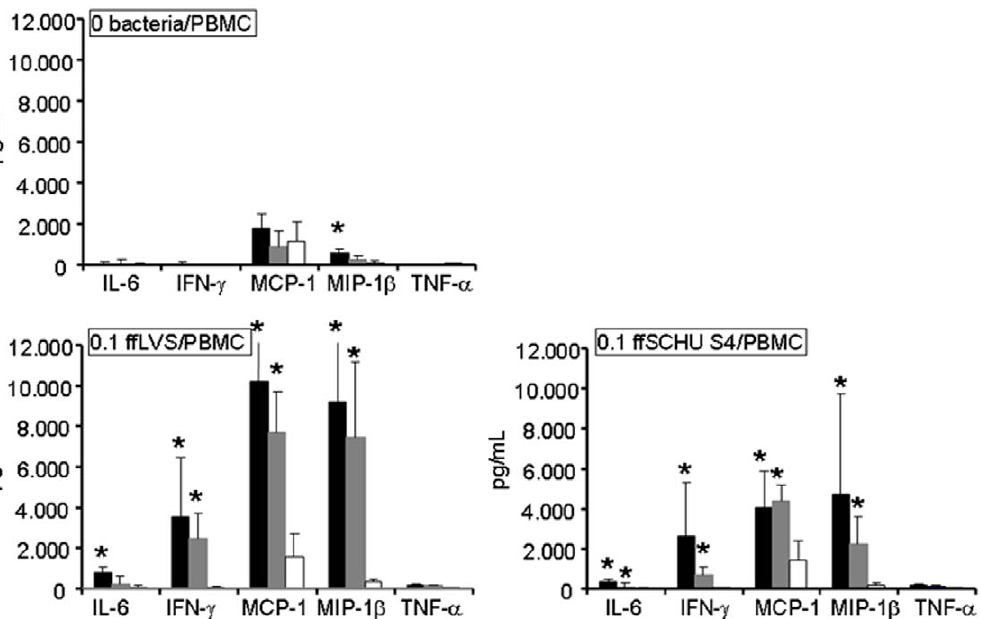
Figure 3. Levels of cytokines secreted by human PBMC after recall stimulation with ffLVS or ffSchu S4 for five days. Cytokine concentrations were measured in cell culture supernatants using multiplex analysis. Median values 6 SEM from PBMC samples of 14–16 individuals per donor group are shown (black bars indicate convalescent patients; grey bars indicate LVS vaccinees; white bars indicate naı¨ve donors). Statistically significant differences between immune and naı¨ve donors are marked by asterisks ( P , 0.05).